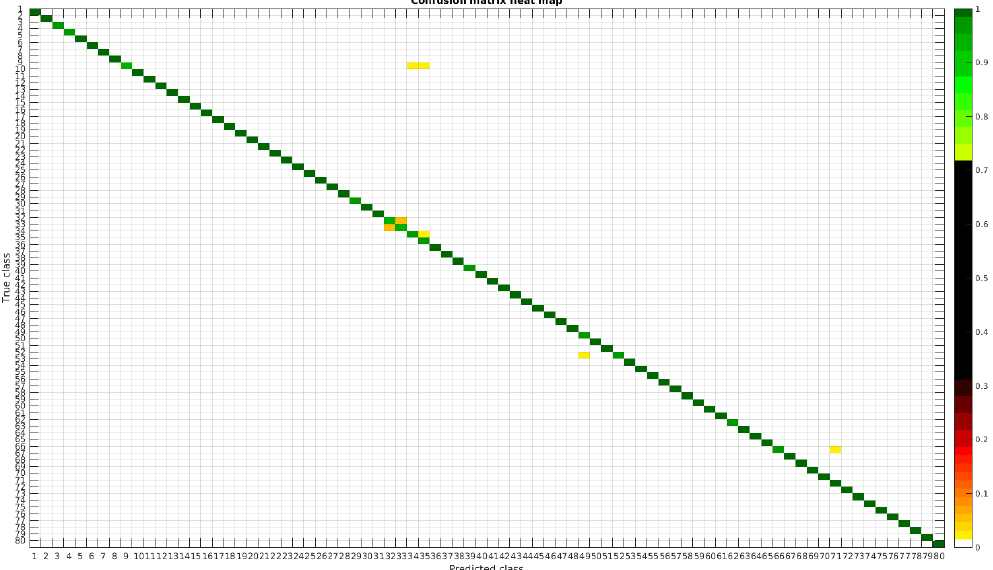
Figure 7. Confusion matrix heat map for the original dataset with 1000 samples per